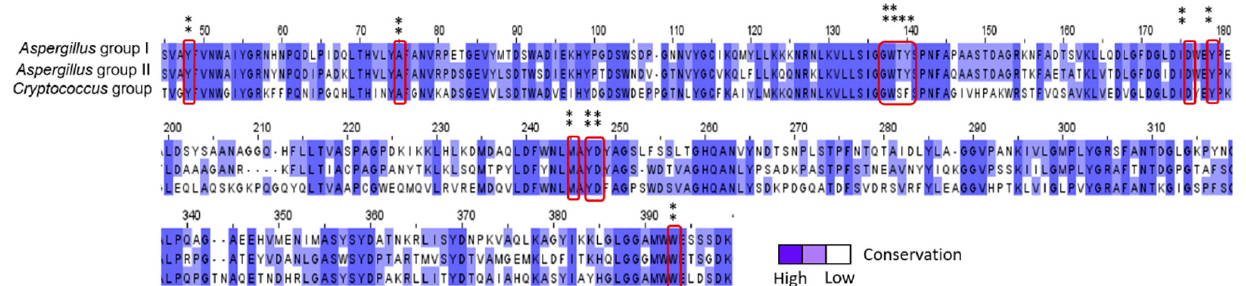
Figure 1. Fungi consensus sequences and highlighted main amino acid residues in the binding site. Aspergillus consensus sequence group I and II represents various Aspergillus species, and the Cryptococcus group is composed of neoformans variant grubii and gattii species. * Refers to low conservated sequences and ∗ refers to high conservation in sequences.